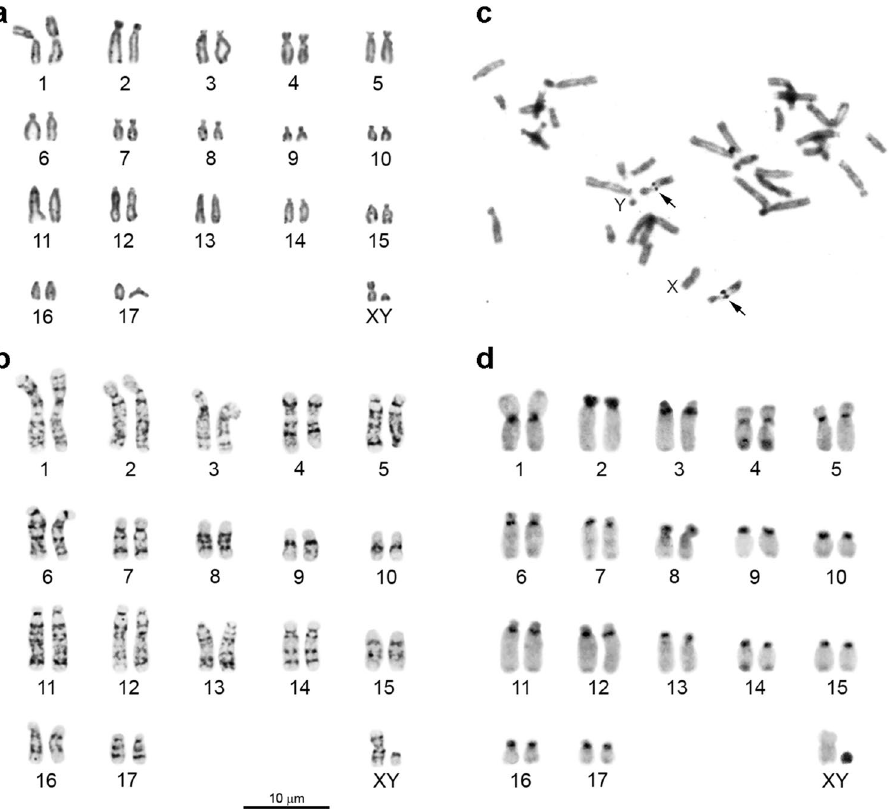
Figure 2. A male karyotype of Uropsilus soricipes from Sichuan Province (Zoige). ( a ) Conventional staining, ( b ) G-banding, ( c ) C-banding and ( d ) silver nitrate staining. Arrows indicate nucleolus organiser regions (NORs). 2n = 36, NF a = 54. XY: sex